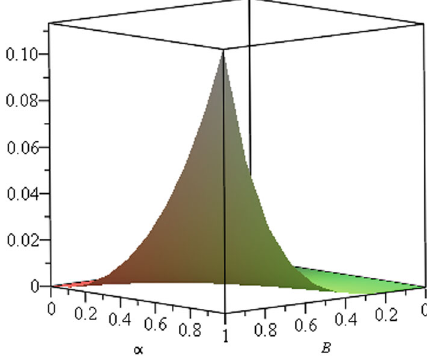
Fig. 5 The plot shows the classical stability with variables α , β and B